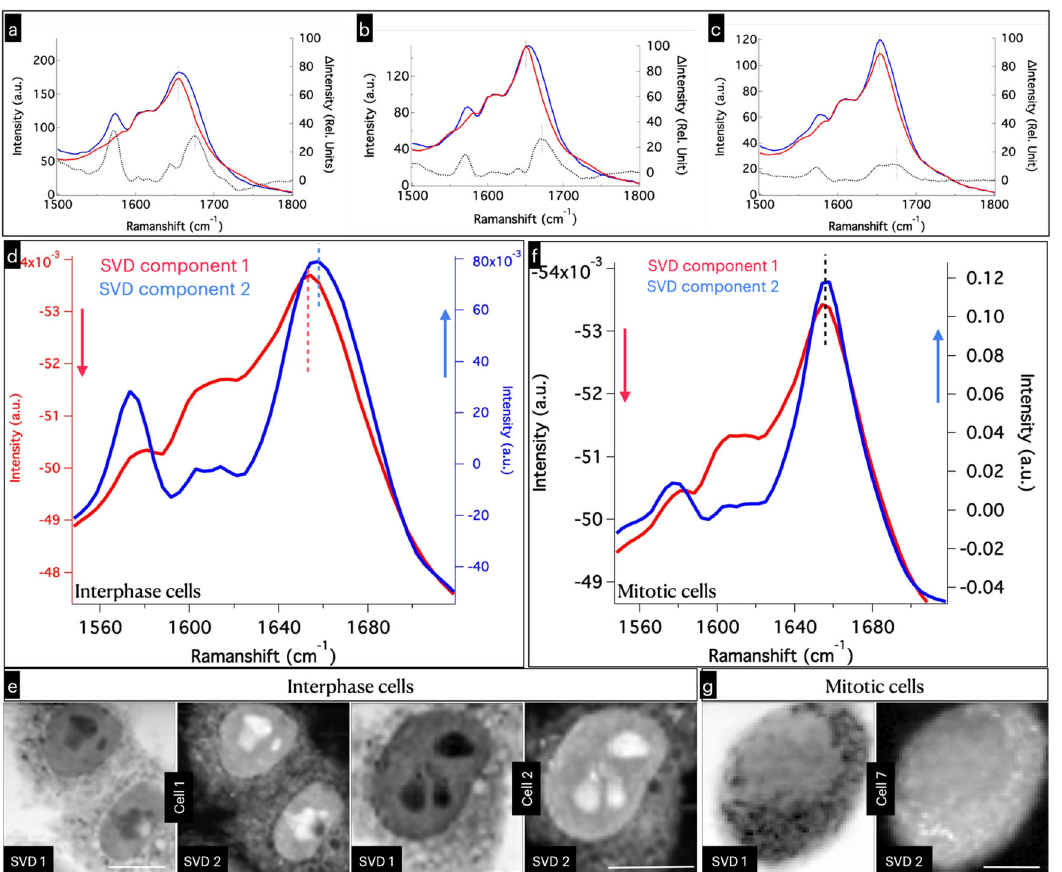
Fig. 4 Analysis of amide I region of Raman spectra corresponding to proteins. Amide-I region of the average Raman spectra from LLPS (blue) and cytoplasmic regions (red). Strong 1573 cm − 1 nucleic acids band can be seen. Amide I bandwidth changes are evident from the plots, which indicates changes in the secondary structure of proteins during LLPS aggregate formation ( See also fi g. S12). Black traces represent the corresponding difference spectra. a HeLa, b H1650, and c H1975. Results of SVD analyses ( d – g ). d First two SVD components from the interface cell Raman images. Amyloid-like spectral feature can be noted in SVD component 2 (Blue). e The corresponding interphase cell SVD images. f First two SVD components from the mitotic cell Raman image. Amyloid-like spectral feature is absent here. g The corresponding mitotic cell SVD images. Scale bar 10 µ m. The full list of SVD spectra and SVD images are given in Fig.